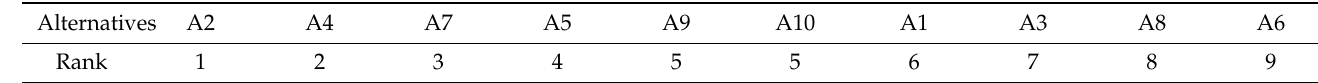
Table 7. Results of ANN.